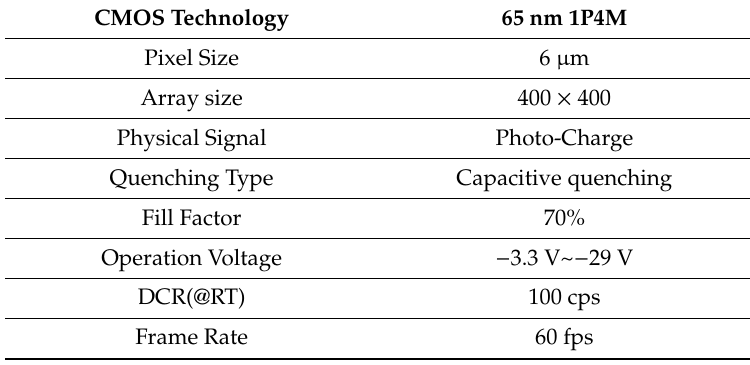
Table 2. Specifications of the fabricated SPAD-based CMOS image sensor